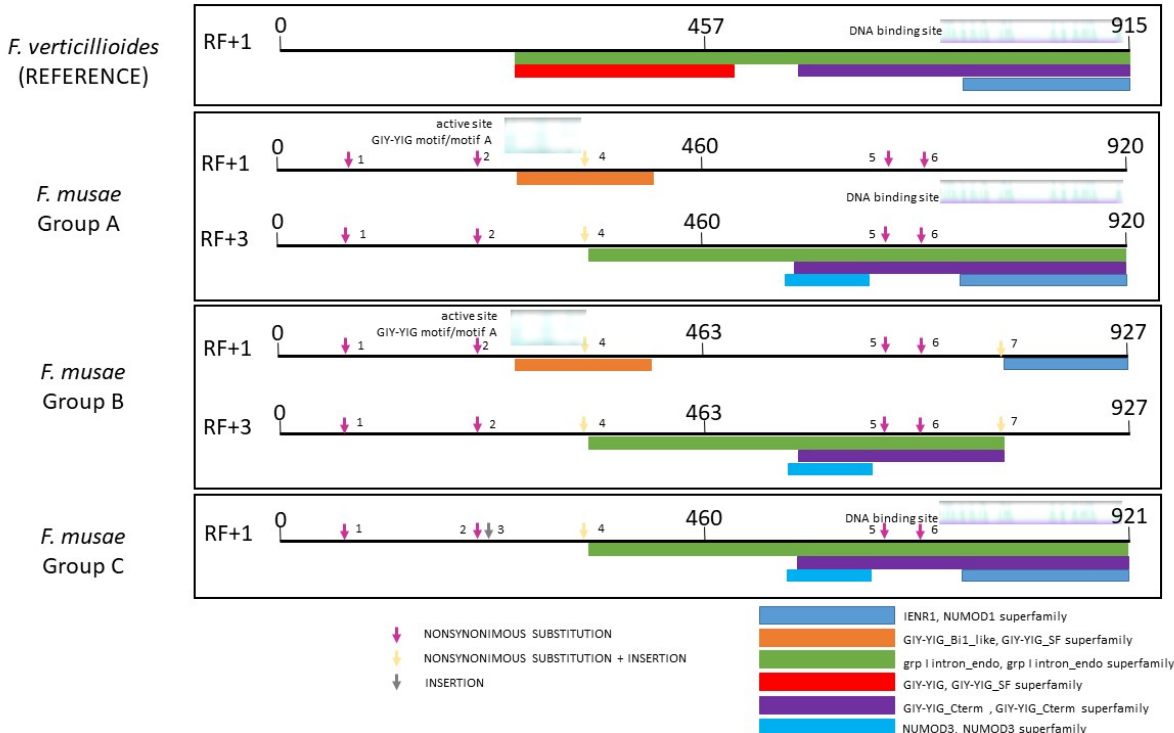
Figure 3. BlastX results of the intron of nad1 gene in F. verticillioides and in F. musae strains. Types of endonuclease functional domains are visible. Numbers near arrows indicate different types of variations of the intron gene in F. musae strains compared to functional endonuclease in F. verticillioides (details on the alignment can be observed in Supplementary Figure S1). Group A includes: IHEM19981, ITEM1121, ITEM1142, ITEM1149, ITEM1250, IUM_11-0508, IUM_11-0507, MUCL51371, NRRL25673, NRRL43601, NRRL43604, NRRL43658, NRRL43682; group B: IHEM20180, NRRL25059, NRRL28893, NRRL28897; group C: F31.